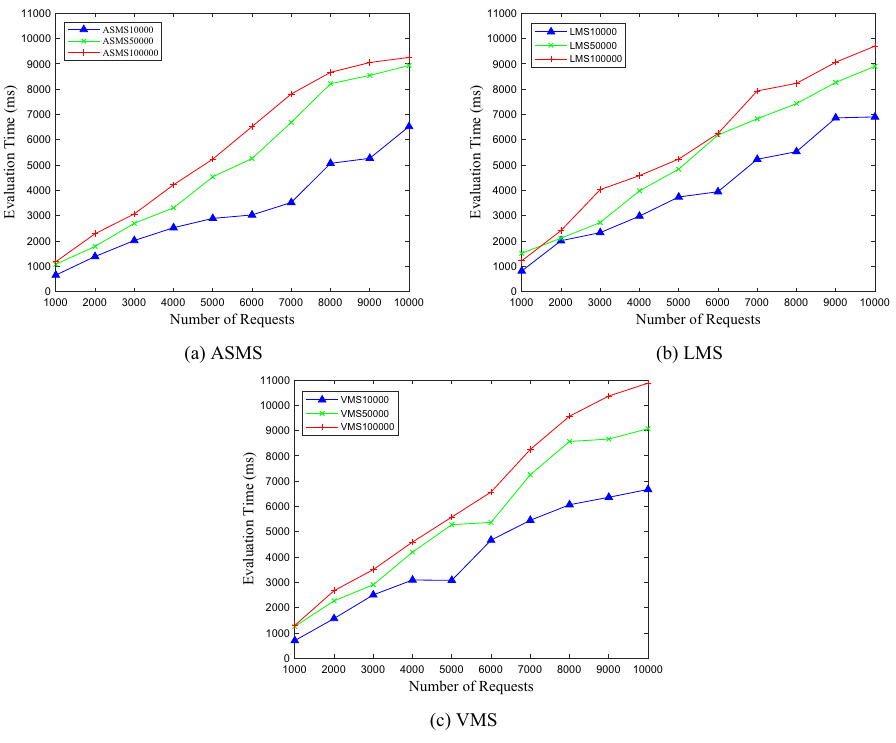
Figure 14. Comparison on different sizes policy sets.